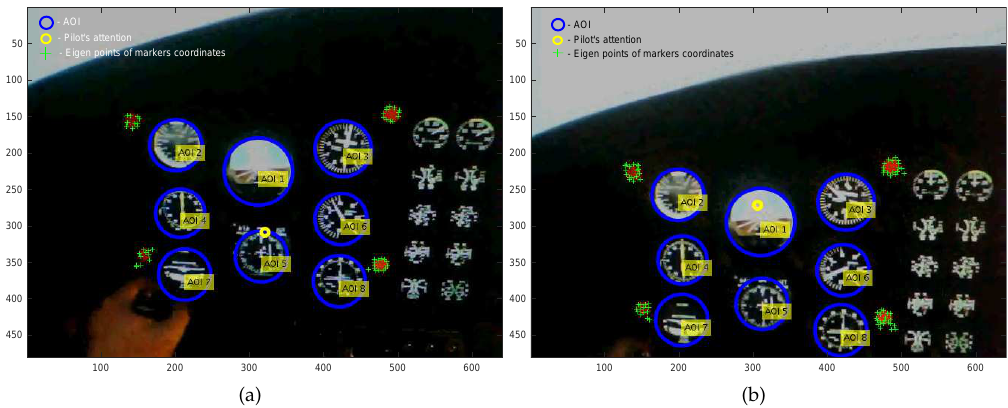
Figure 10. An example of the not satisfied ( a ) and satisfied ( b ) condition of the containment of pilots’ eye attention within